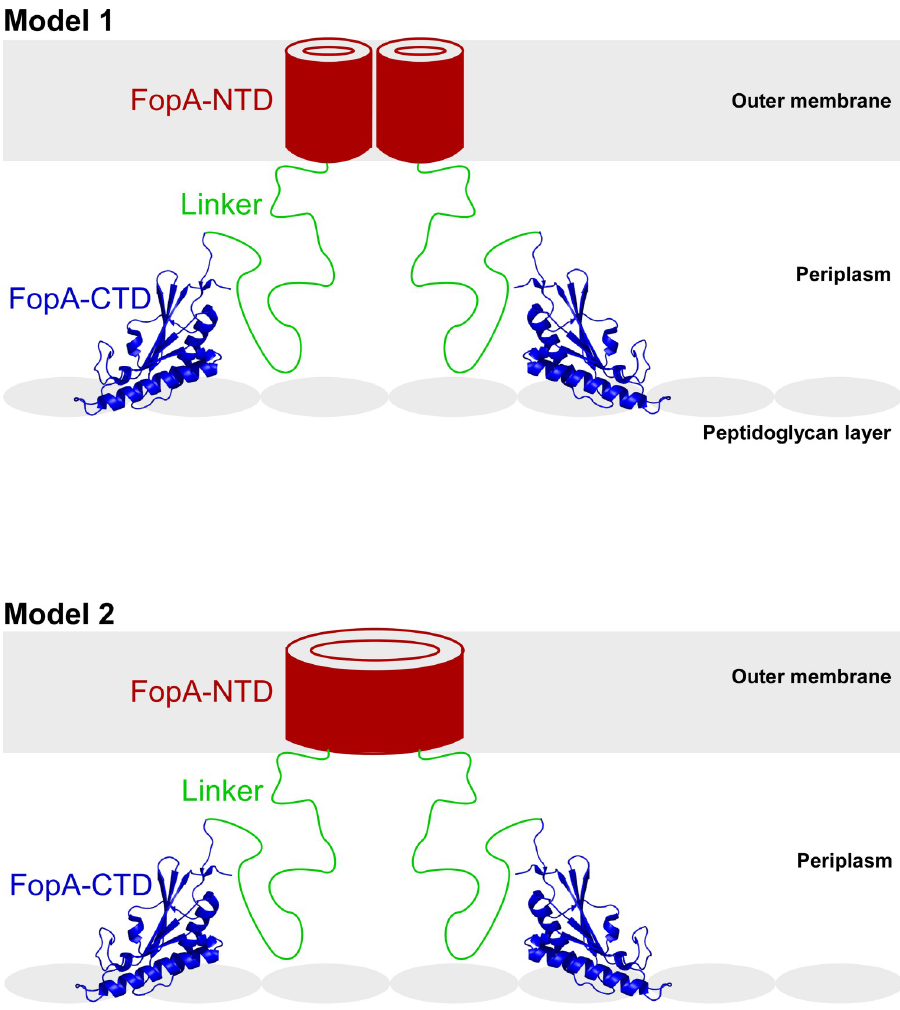
Fig 9. Proposed models of the structural organization of FopA in the outer membrane. FopA forms a dimer. FopA-NTD (red) folds into a β -barrel and is embedded in the outer membrane, FopA-CTD (blue; PDB ID 6U83) reside in the periplasm and interacts with the peptidoglycan layer and the long flexible linker (green) tethers both domains. Model 1 : the two NTDs may form two individual narrow pores; Model 2: β -strands of both NTDs may rearrange and refold into a single large